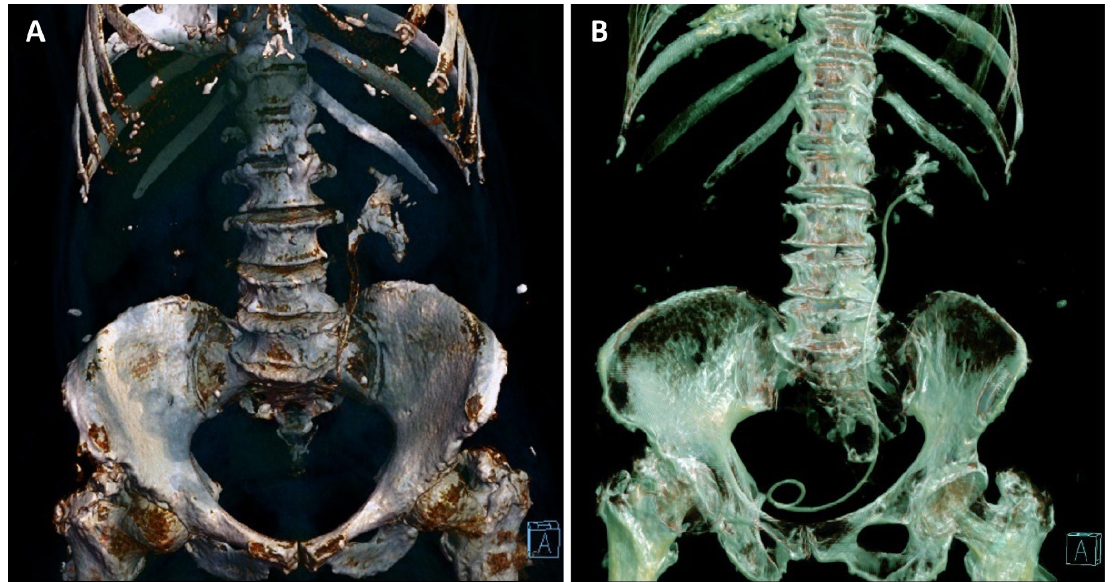
Figure 4. Three-dimensional reconstruction based on the non-contrast CT examinations of the pa- tient at the moment of diagnosis ( A ) and on the sixth week follow-up visit ( B ), with the ureteric stent in place, showing the partial regression of the pyelic and calyceal calcifications, and the complete regression of the upper ureter